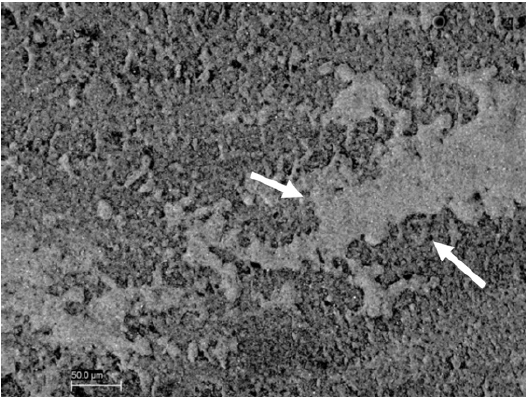
(H) composite resin; (I) adhesive layer (it is possible to see the points where it penetrates into the